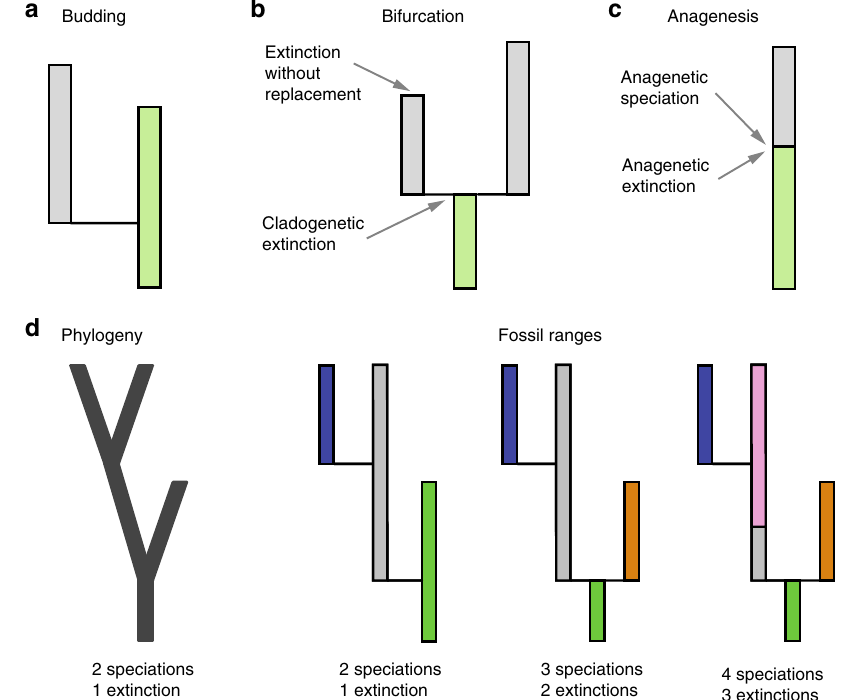
Fig. 1 Speciation modes re fl ecting the difference in phylogenetic and stratigraphic interpretations of speciation and extinction rates. a – c Three alternative modes of speciation 39 . Each rectangle corresponds to a distinct species with green-shaded rectangles representing ancestral species. a Cladogenesis via budding: one new species arises, the ancestral species survives. This type of speciation happens with rate λ (1 − β ) in the BDC model. b Cladogenesis via bifurcation: the ancestral species goes extinct and two new species arise with rate λβ . c Anagenesis: the ancestral species goes extinct and is replaced by one new species with rate λ a . d Phylogenetic versus stratigraphic interpretations of speciation and extinction rates. The phylogeny on the left describes three possible speciation histories (three coloured trees on the right). The coloured segments represent distinct (morpho)species. Phylogenetic estimates of speciation and extinction rates, λ and μ , differ from fossil-based estimates, λ * and μ *, in two out of the three cases. The rates are only the same in the case of pure budding speciation (the fi rst coloured tree from the